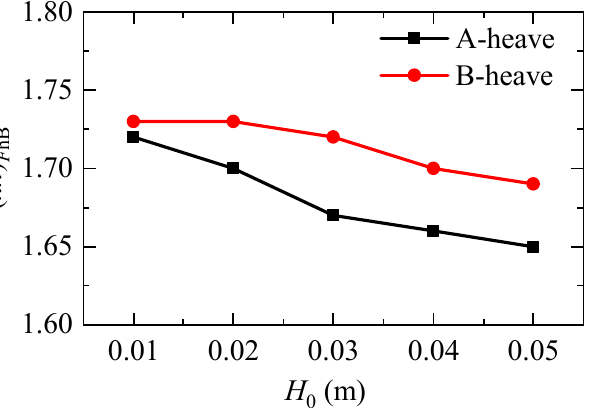
Figure 8. Variations of the normalized largest horizontal wave forces on Box B, [ F h B /( ρ ghA 0 W )] max , against the incident wave height for both structure systems.